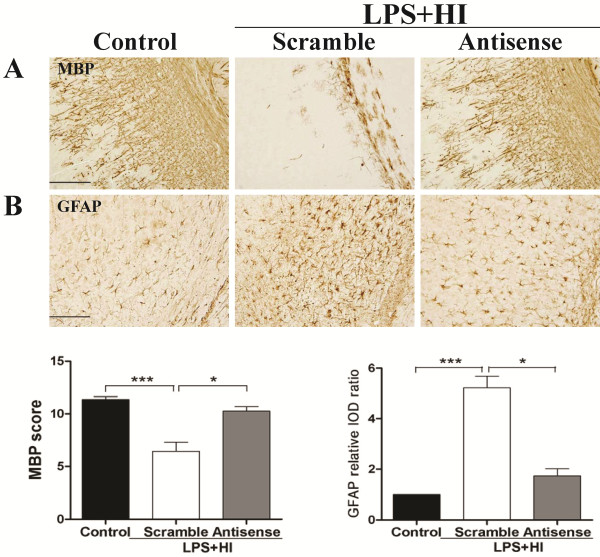
c-Jun N-terminal kinase (JNK) antisense oligodeoxynucleotide significantly attenuated white matter injury. Antisense oligodeoxynucleotide (ODN) treatment (n = 8) markedly increased myelin basic protein (MBP) (A) and decreased glial fibrillary acidic protein (GFAP) (B) expression in the white matter compared with scrambled ODN (n = 8) on P11 after lipopolysaccharide (LPS)-sensitized hypoxic-ischemia (HI) on P2. Scale bar = 200 μm in (A), 100 μm in (B). Values are means ± SEM. ***P < 0.001, *P < 0.05.